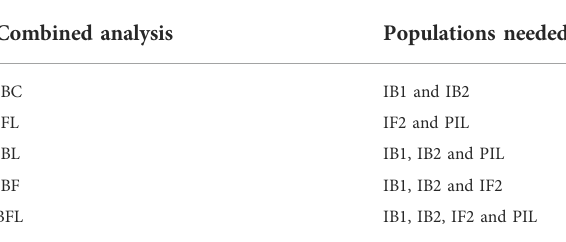
TABLE1NamingofthecombinedQTLmappinginfunctionalitiesQHP and SHP. Combined